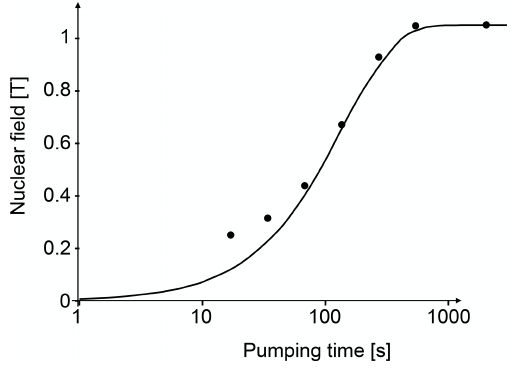
Figure 22. Build-up of the nuclear field during optical pumping.